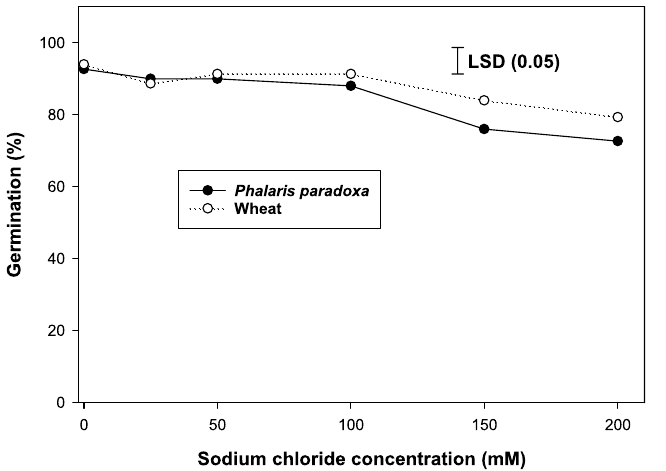
Figure 4. Effect of sodium chloride concentration on germination of Phalaris paradoxa and wheat seeds at alternating day/night temperatures of 20/10 °C under 12 h photoperiod. Seeds were incubated for 21 d. LSD: Least significant difference at the 5% level of significance.